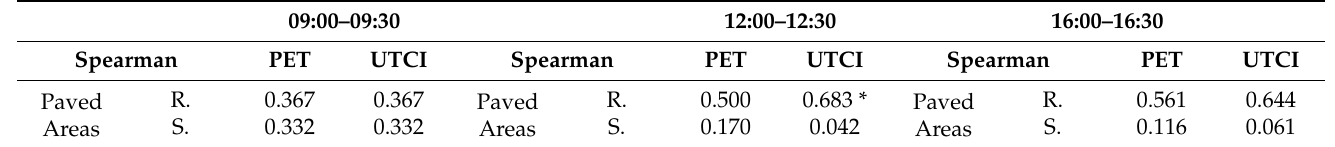
Table 5. The Spearman correlation coefficients of the paved areas ratio and PET and UTCI.